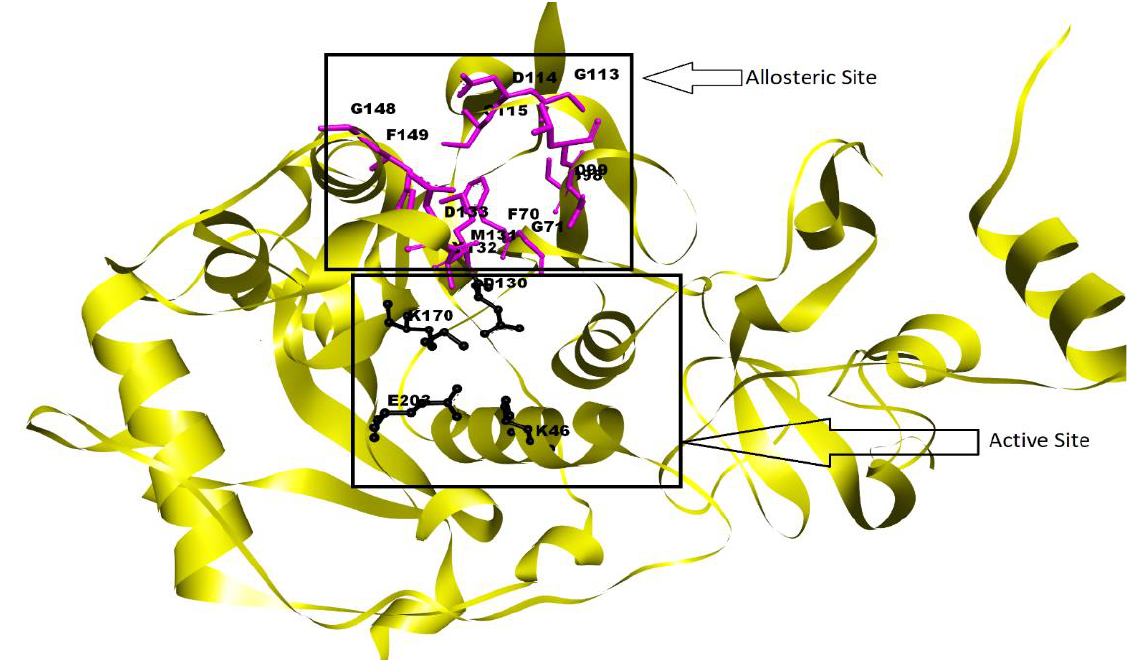
Figure 1. SARS-CoV-2 MTase active site residues are highlighted with black coloring, and allosteric site residues are highlighted with purple coloring; both are also labeled [17]. Table 1. SARS-CoV-2 MTase allosteric site